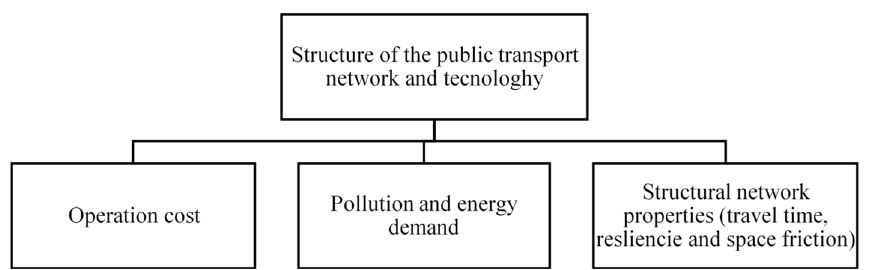
Figure 2. Conceptual relationship among main aspects of a transit system.